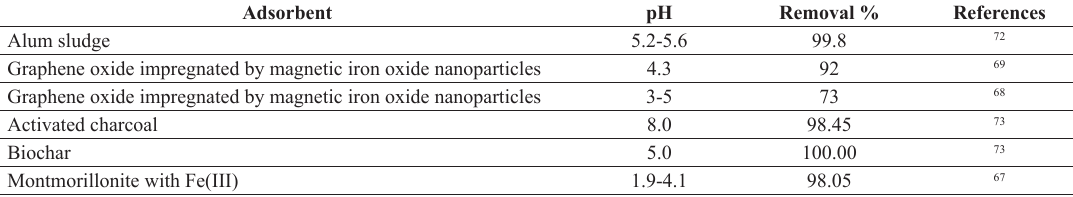
Table 7. Efficiency and pH of the adsorptive process of some materials for glyphosate removal. Adsorbent